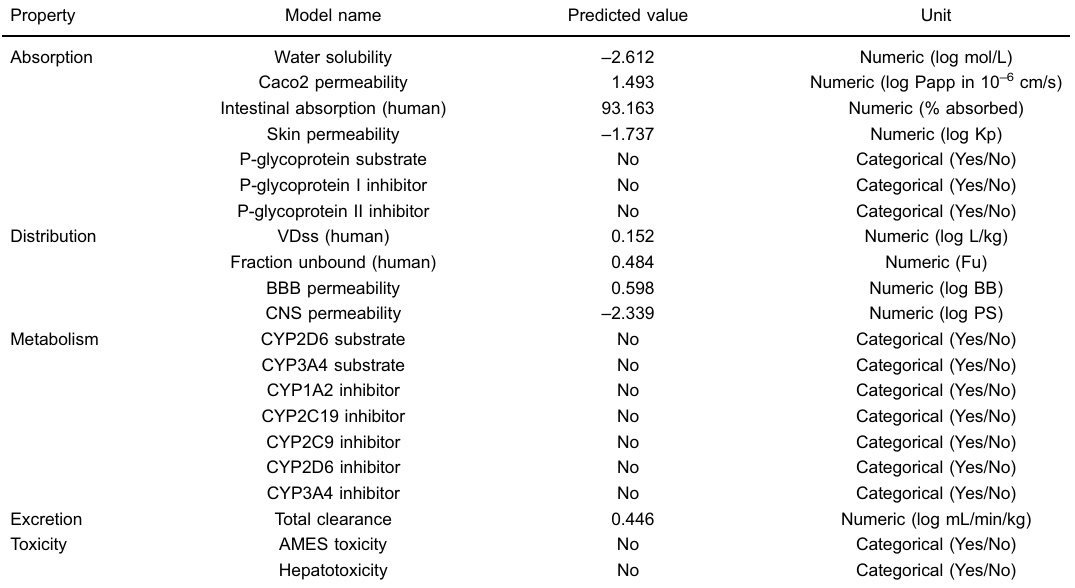
Table 5. In silico physicochemical and pharmacokinetic parameters of linalool. Property